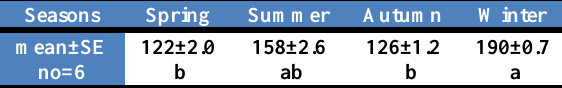
Table, 2: Tubular diameter (µm) during different seasons in dog.